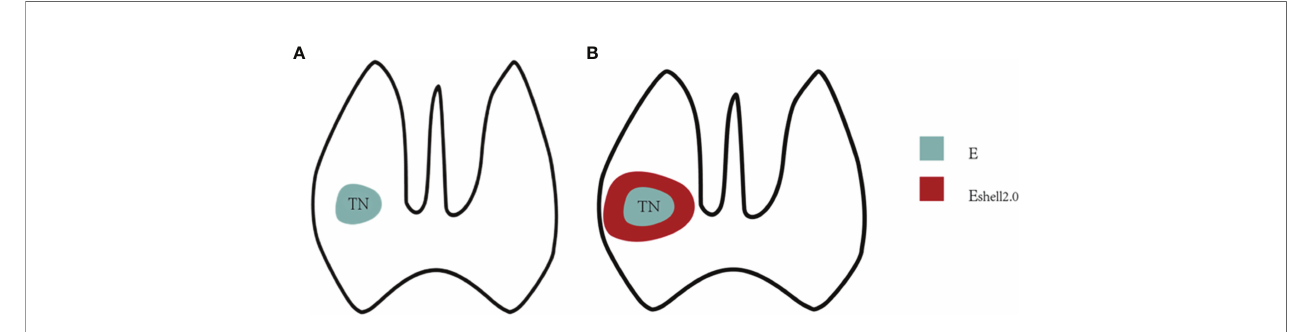
FIGURE 2 | Shell measurement diagram. (A) E value was the interior stiffness of the TN. (B) E shell value referred to 2 mm-perinodal stiffness of the